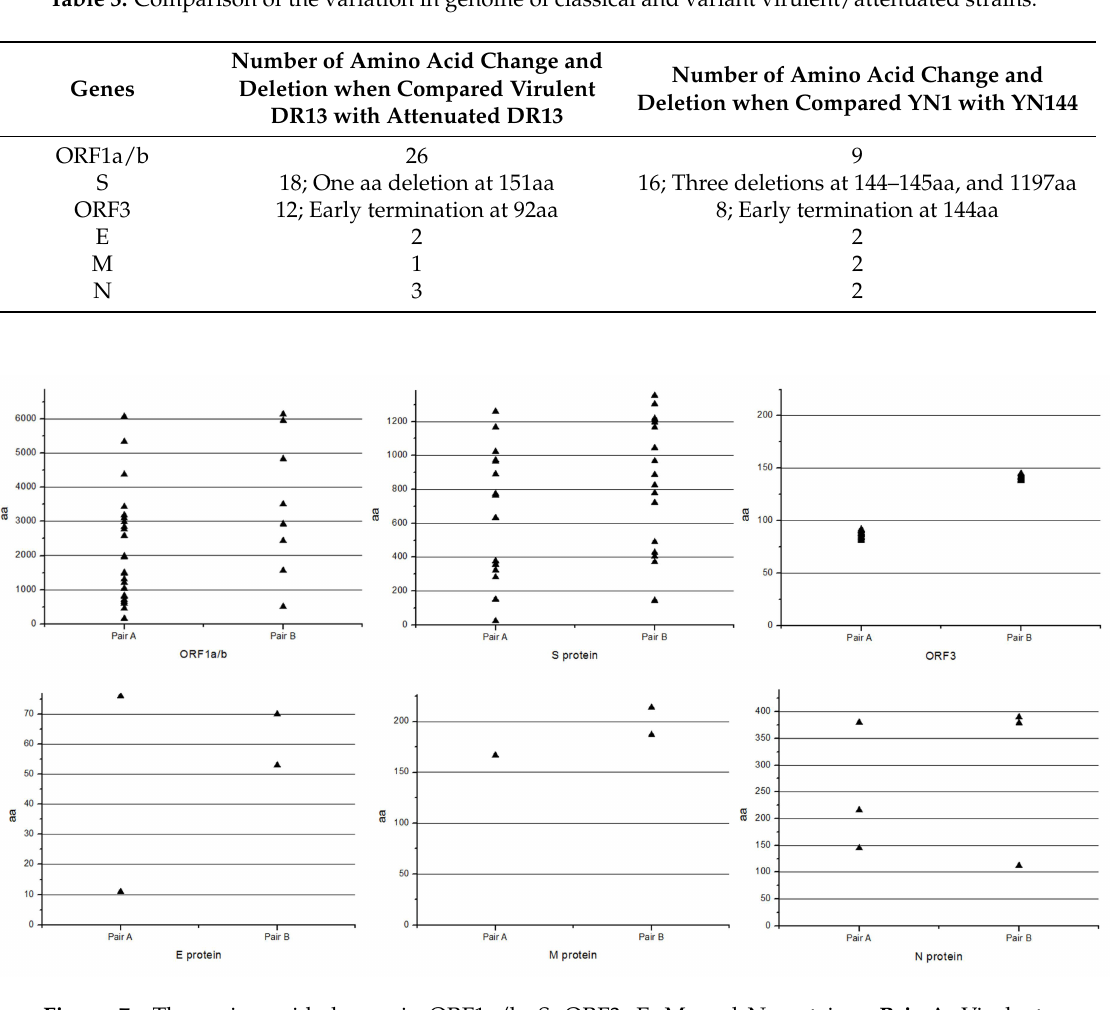
Figure 7. The amino acid change in ORF1a/b, S, ORF3, E, M, and N proteins. Pair A : Virulent DR13/Vaccine DR13; Pair B : YN1/YN144.The X-axis represents the aa changes in the vaccine DR13 and YN144, and the Y-axis represents aa change position. The upper triangle represents one mutated amino